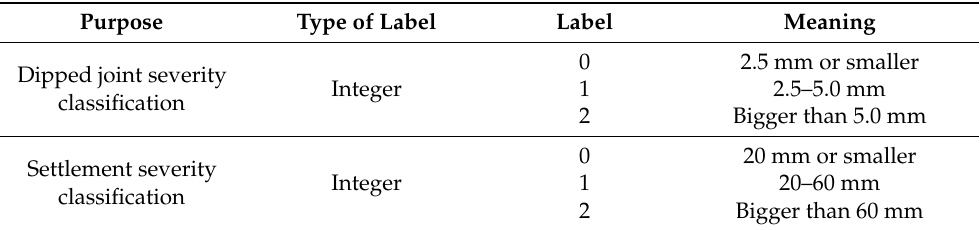
Table 3. A summary of the label for each